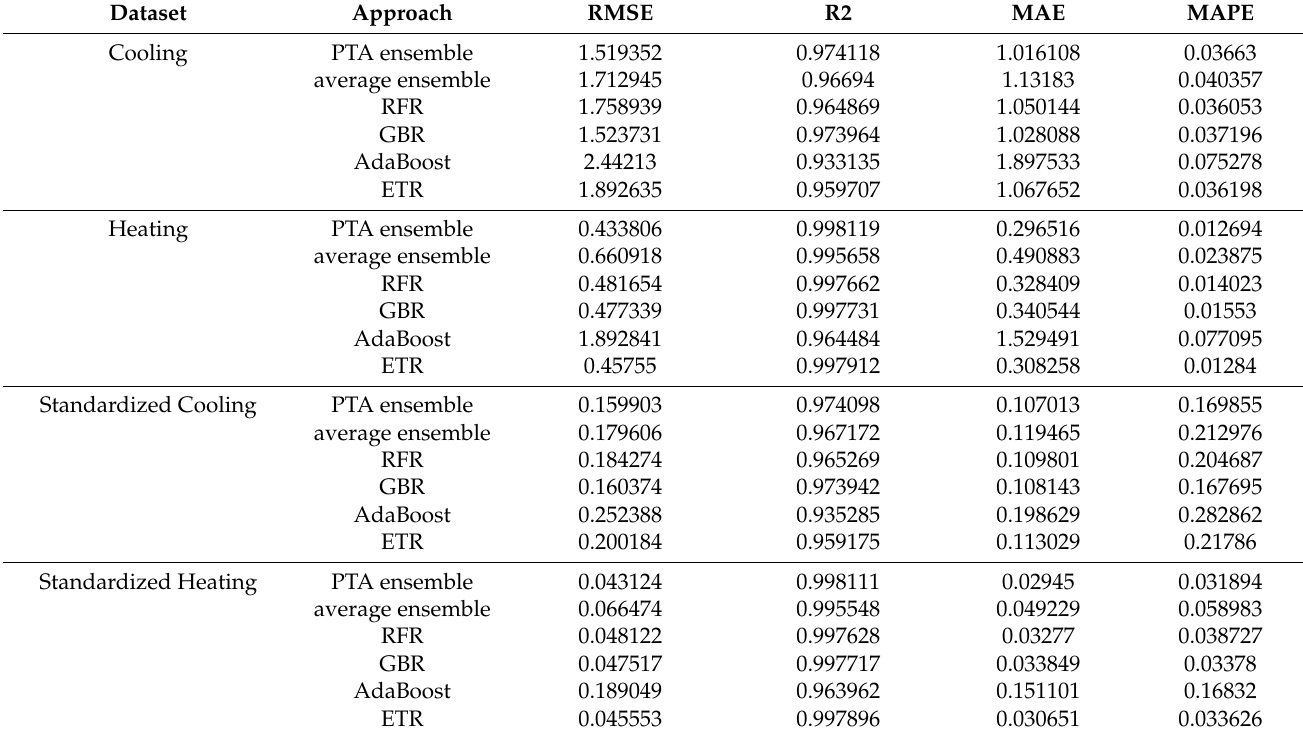
Table 11. Comparison to the Average Ensemble and the Individual Components of the